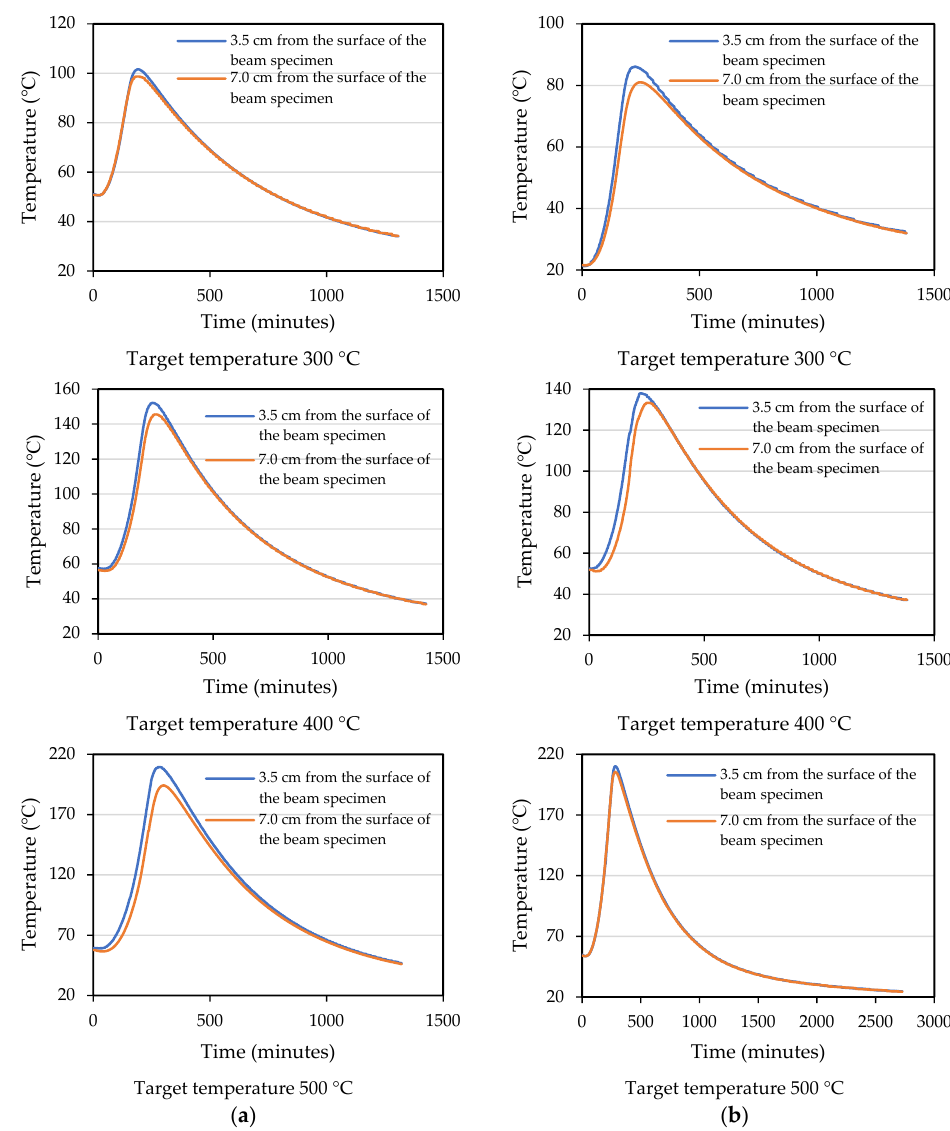
Figure 7. The relationship between the specimen internal temperature and time: ( a ) the experimental group and ( b ) the control group.